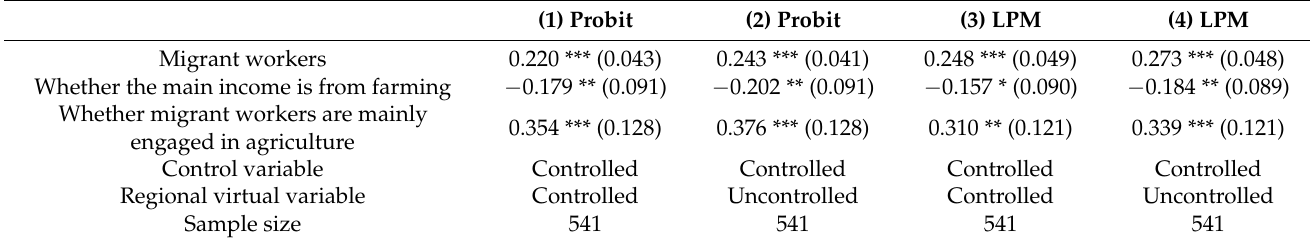
Table 4. Analysis of the impact of migrant workers on farmers’ access to productive agricultural